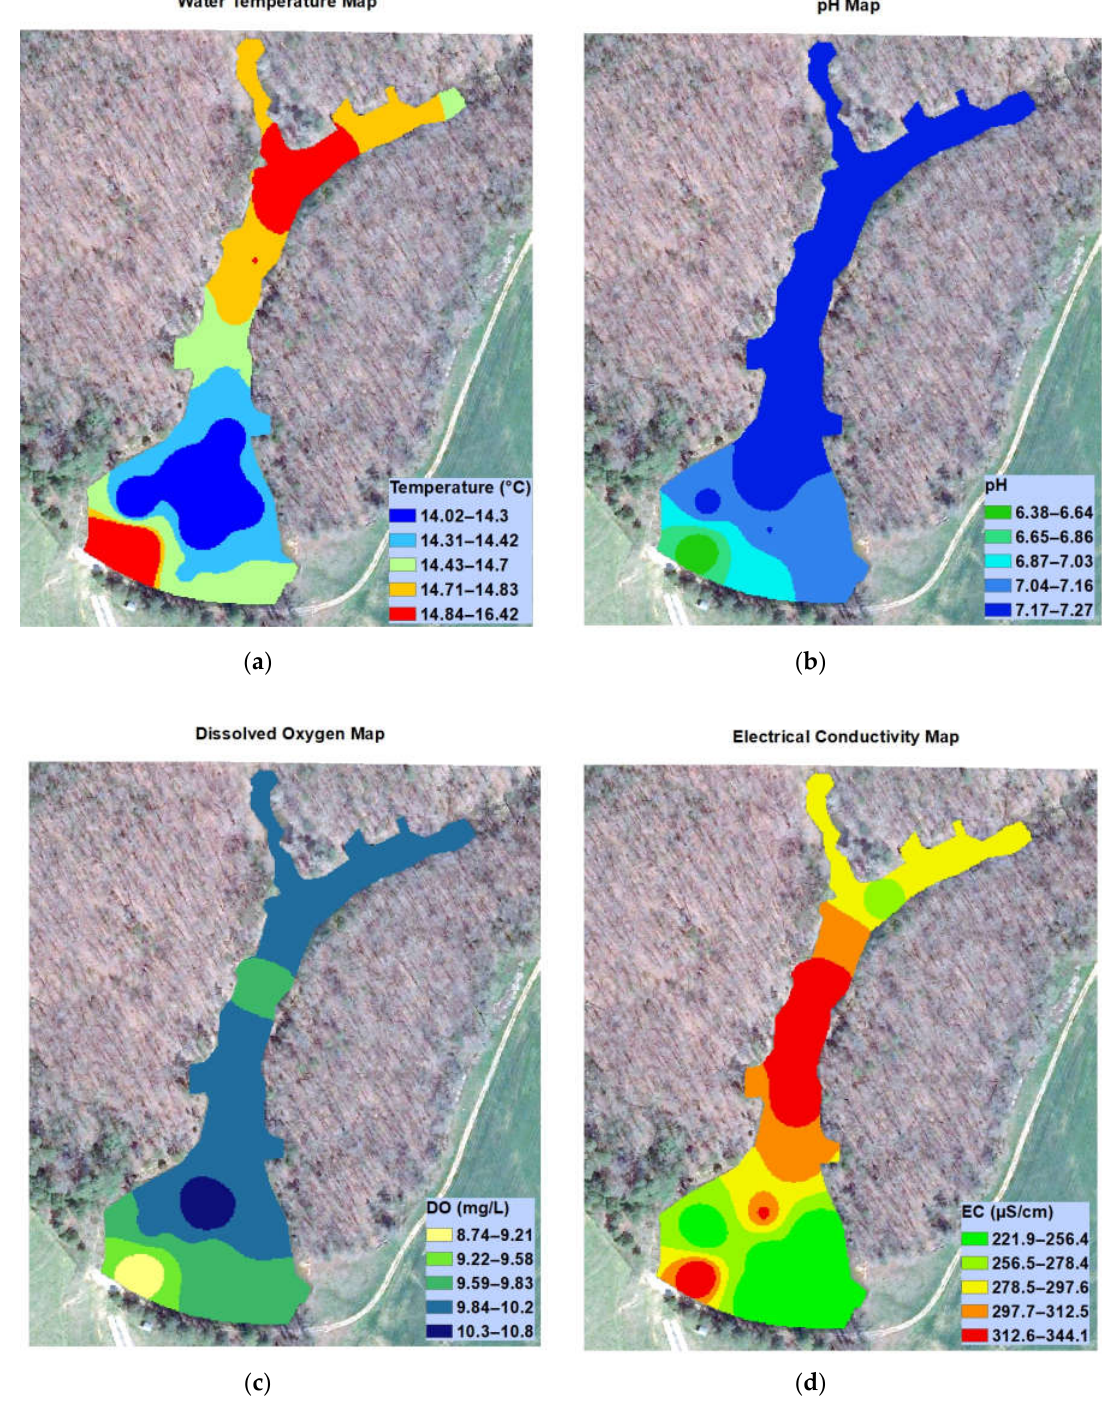
Figure 8. Spatially interpolated data from the UAMS: Water quality maps showing ( a ) water temperature, ( b ) pH, ( c ) dissolved oxygen, and ( d ) electrical conductivity.